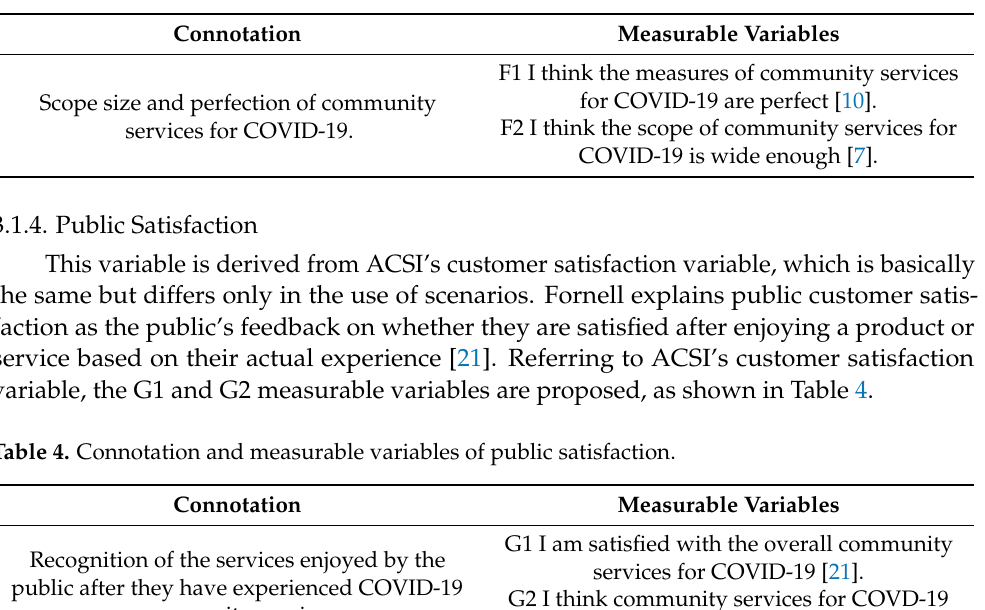
Table 3. Connotation and measurable variables of service maturity.